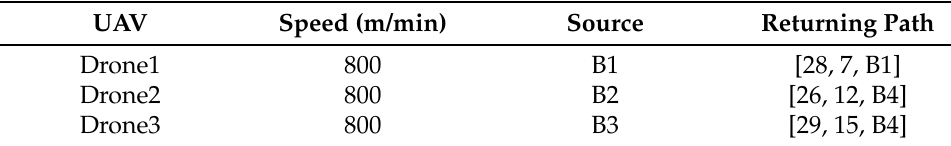
Table 7. Data delivery when UAVs may be late for more than 60 min.